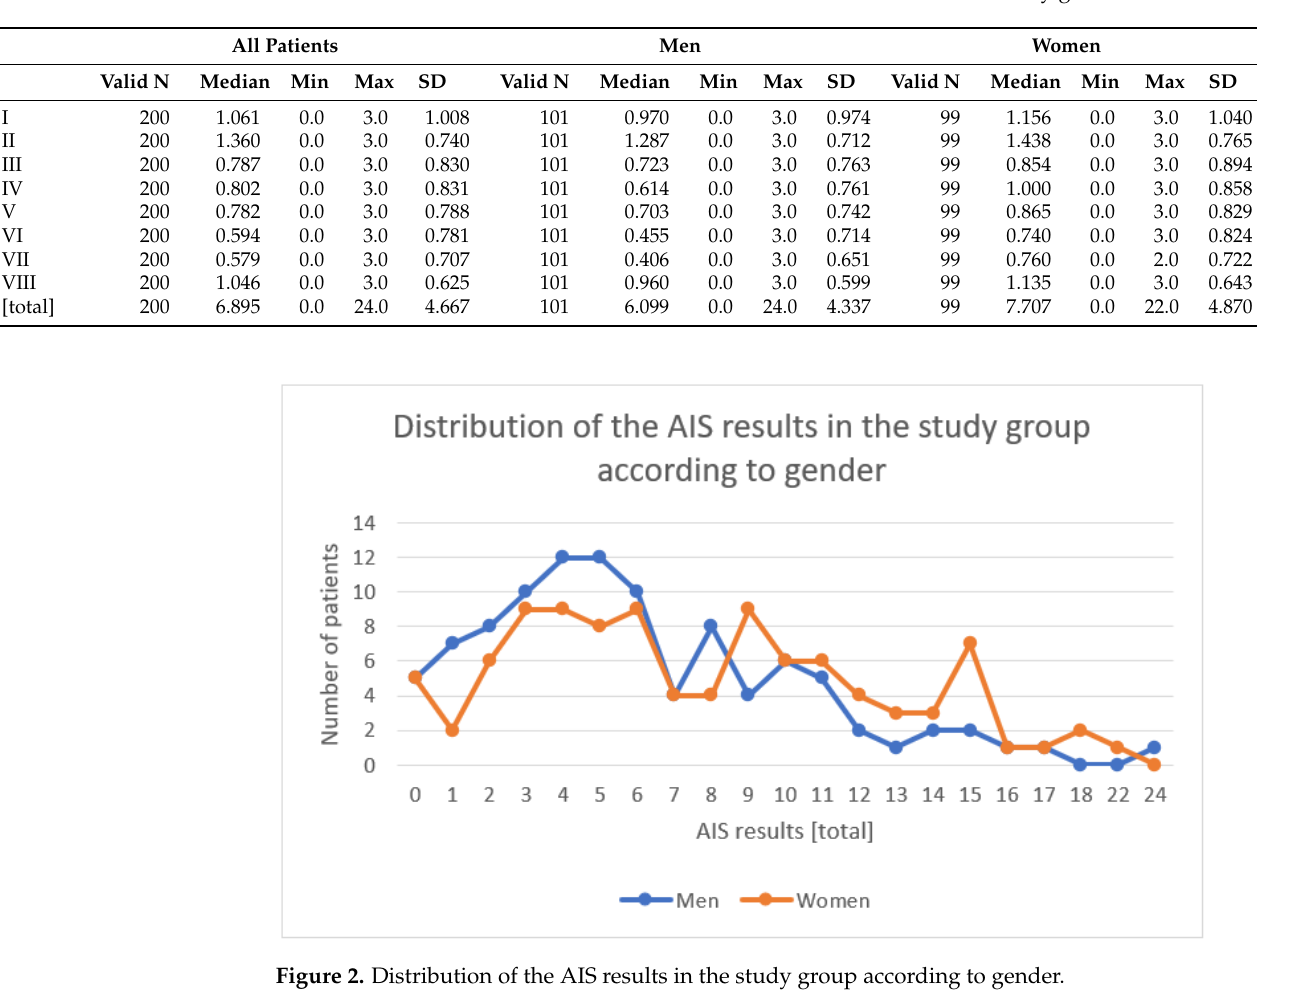
Figure 2. Distribution of the AIS results in the study group according to gender. A comparison of the results obtained by the men and women in the AIS shows a significant difference depending on gender: women achieved a higher overall score but also higher scores in the questions assessing total sleep time, well-being the next day, physical and mental fitness the next day, and sleepiness during the day ( p < 0.05). The results are presented below (Figures